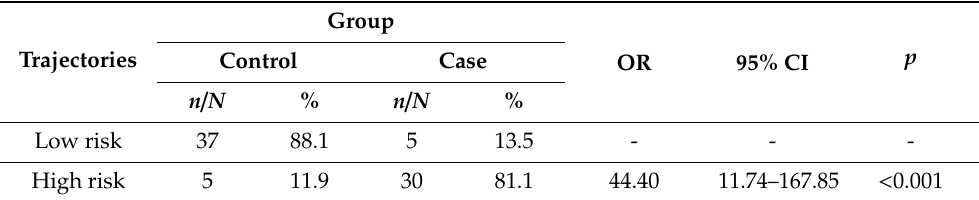
Table 5. Low / high risk GMs trajectories and neurological outcome.